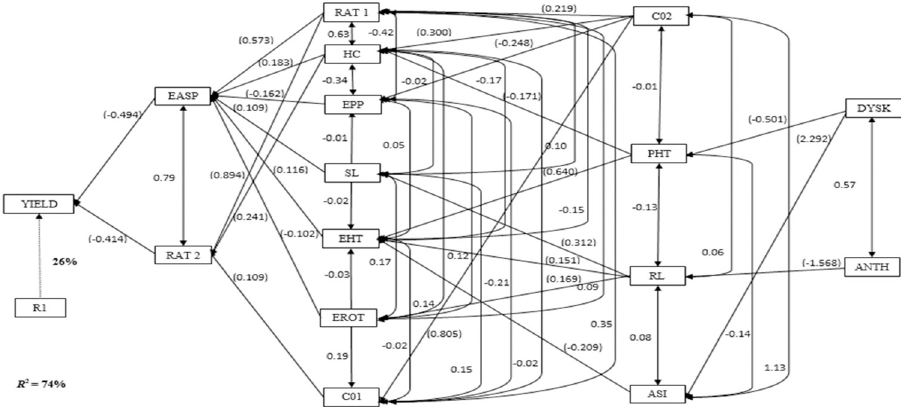
Fig 2. Path analysis model diagram showing causal relationships of measured traits of early maturing provitamin A maize hybrids evaluated under Striga infested conditions in Mokwa and Abuja. R 2 = co-efficient of determination; R1 = residual effects; YIELD = grain yield; EASP = ear aspect; EPP = ears per plant; ANTH = days to 50% anthesis; SL = stalk lodging; ASI = anthesis–silking interval; PASP = plant aspect; DYSK = days to 50% silking; RAT1 and RAT2 = Striga damage rating at 8 and 10 WAP, respectively; C01 and C02 = number of emerged Striga plants at 8 and 10 WAP, respectively; PHT = plant height; EHT = ear height; HC = husk cover; RL = root lodging; EROT = ear